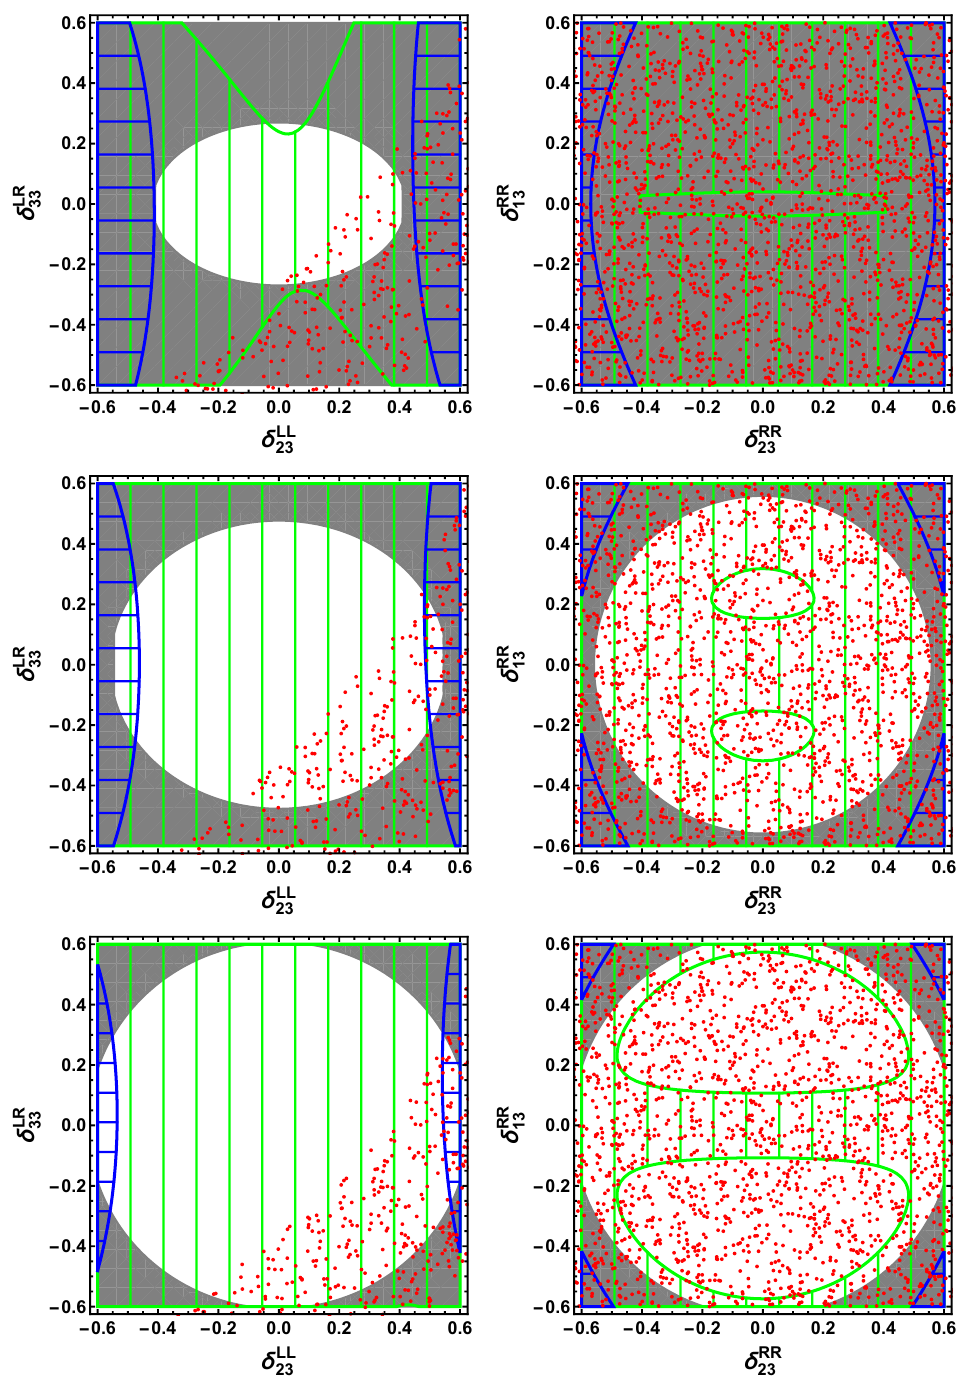
Figure 6 . Allowed regions for (cid:14) LL panel), respectively. Here (cid:14) LR 1300 (middle), and 1500 GeV (lower), respectively. The red dot area is allowed by B s(cid:13) , while the green and the blue hatched area by (cid:1) M d and (cid:1) M s , respectively. The gray areas are excluded by the lower bound of 940 GeV on squark masses based on a rough estimate of the LHC direct searches for squarks